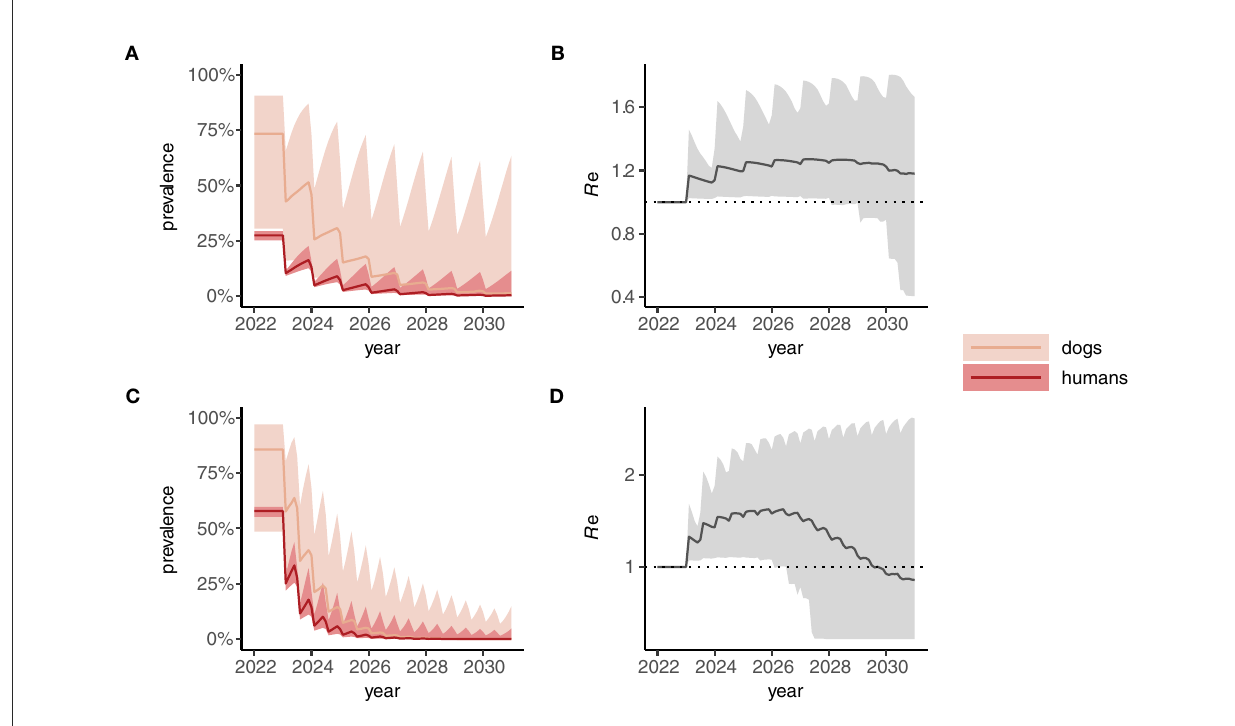
FIGURE4 Dynamics of Anyclostoma ceylanicum infection prevalence during 8 years of “One Health” (dog plus human) mass drug administration (MDA) simulated using the multi-host transmission dynamics model. For illustration, parameter sets were selected that gave an endemic prevalence in humans of 25–30 % (A) and 60–5 % (C). The solid colored lines indicate the median prevalence of infection (from the sampled parameter sets) in dogs and humans (as indicated) during annual (A) or biannual (C) MDA at 75 % coverage in humans and 50 % cover in dogs. The lighter shaded areas indicate the extent of the 5th and 95th percentiles. The associated effective reproduction numbers, R e , are shown in (B) and (D) , the solid line indicating the median and the shaded gray area the 5th and 95th percentiles. Below the threshold R e = 1, transmission is interrupted and the parasite population tends to